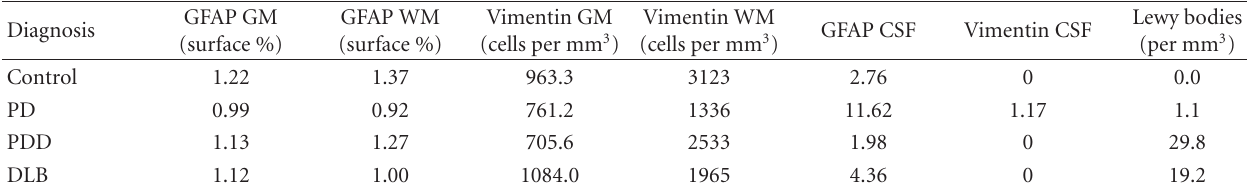
Table 3: Median results per group.